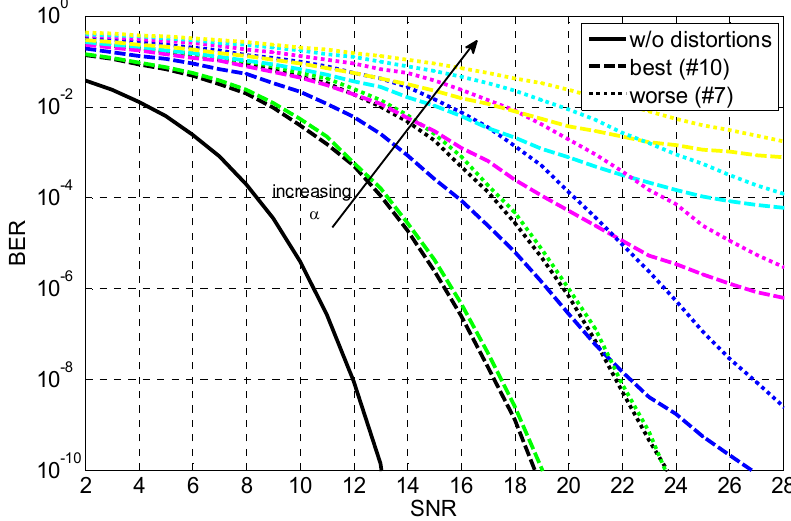
Figure 11. BER vs. SNR for transmission at 10 Gb/s of 32 NRZ-OOK channels with increasing roundtrip losses α = 0, 0.2, 0.4, 0.6, 0.8, 1 in presence of XT. Dashes curves: best channel (#10); dotted curves: worse channel